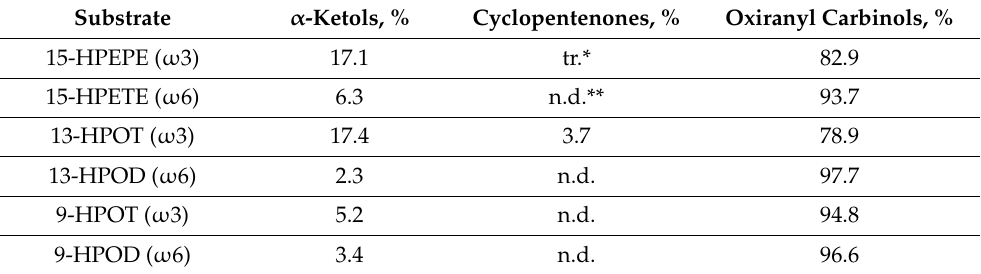
Table 2. Quantitation of the main products of hydroperoxide conversions by the CYP440A18 enzyme. Substrate α -Ketols, % Cyclopentenones, % Oxiranyl Carbinols,